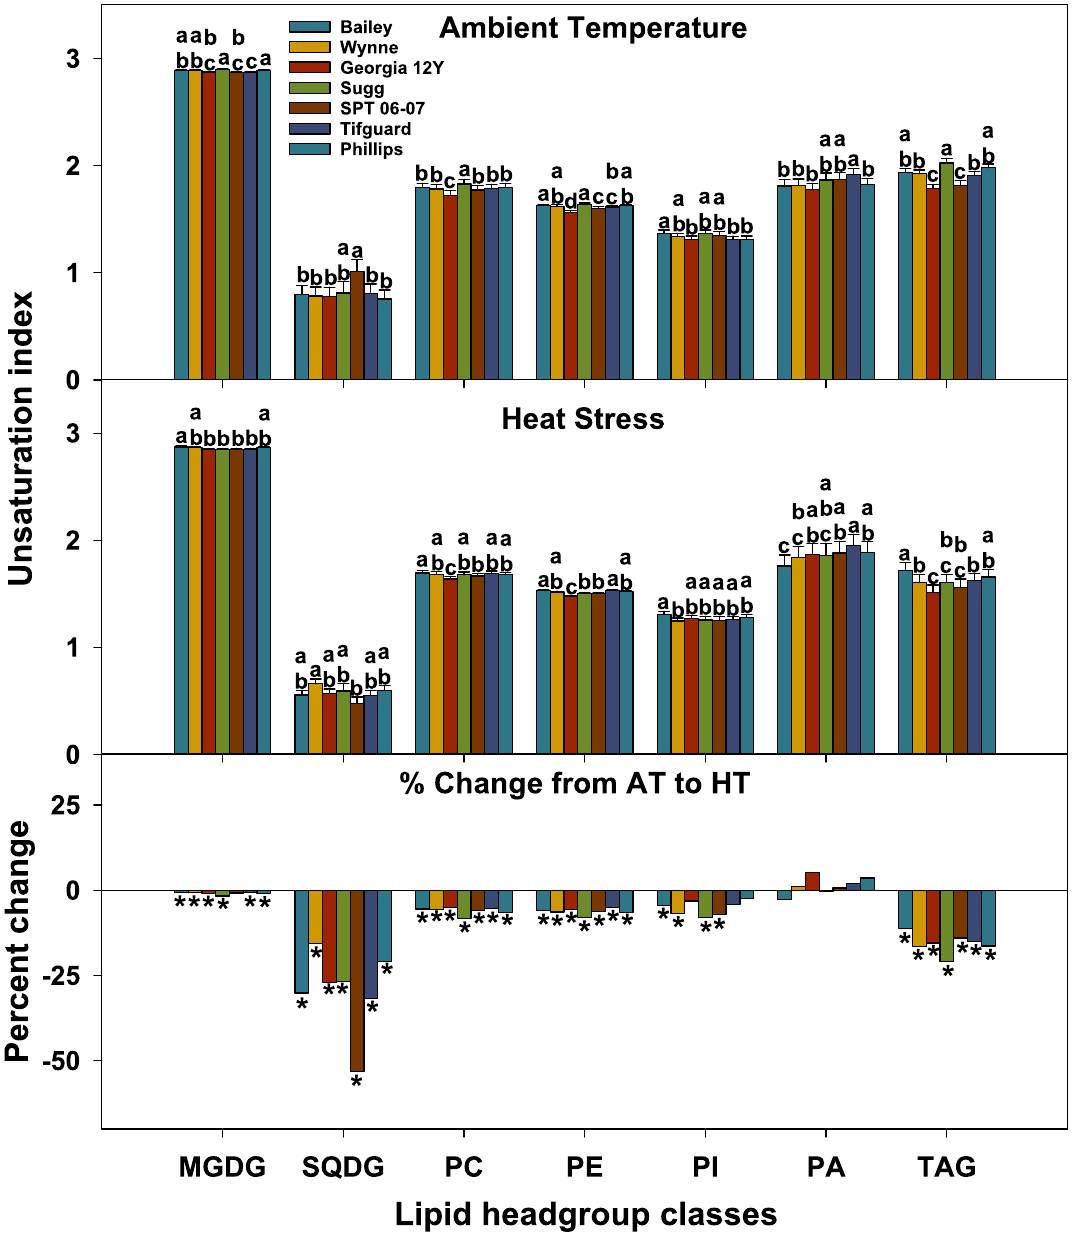
Figure 3. Changes in unsaturation index of various lipid classes in peanut anthers in response to heat stress. The unsaturation index for a lipid molecular species was calculated as the average number of double bonds per acyl chain, which is the number of double bonds in the lipid molecular species divided by the number of acyl chains. The unsaturation index of a lipid headgroup class was calculated as: (cid:31) ( unsaturation indices of individual lipid molecular species in the class × amount of each species ) . Values shown are least squares (cid:31) amount of all lipid molecular species in the class means. Error bars represent standard errors about the least-squares mean of 16 observations (2 years × 2 blocks × 4 replications) except for Sugg and SPT 06-07, which each have 8 observations (1 year × 2 blocks × 4 replications). Least-squares means with different letters are significantly different according to Fisher’s least significant difference (LSD) test at α = 0.05. An asterisk (*) above bars indicate a significant difference at α = 0.05 between AT and HT for that genotype. AT, ambient temperature (31/22 °C for 2018 and 28/22 °C for 2019; average day/night temperatures during the 17- d and 18-d treatment periods in 2018 and 2019, respectively); HT, high temperature (41/27 °C for 2018 and 38/26 °C for 2019). MGDG, monogalactosyldiacylglycerol; PA, phosphatidic acid; PC, phosphatidylcholine; PE, phosphatidylethanolamine; PI, phosphatidylinositol; SQDG, sulfoquinovosyldiacylglycerol; TAG, triacylglycerol. Data from 2 years (2018 and 2019) were pooled together for